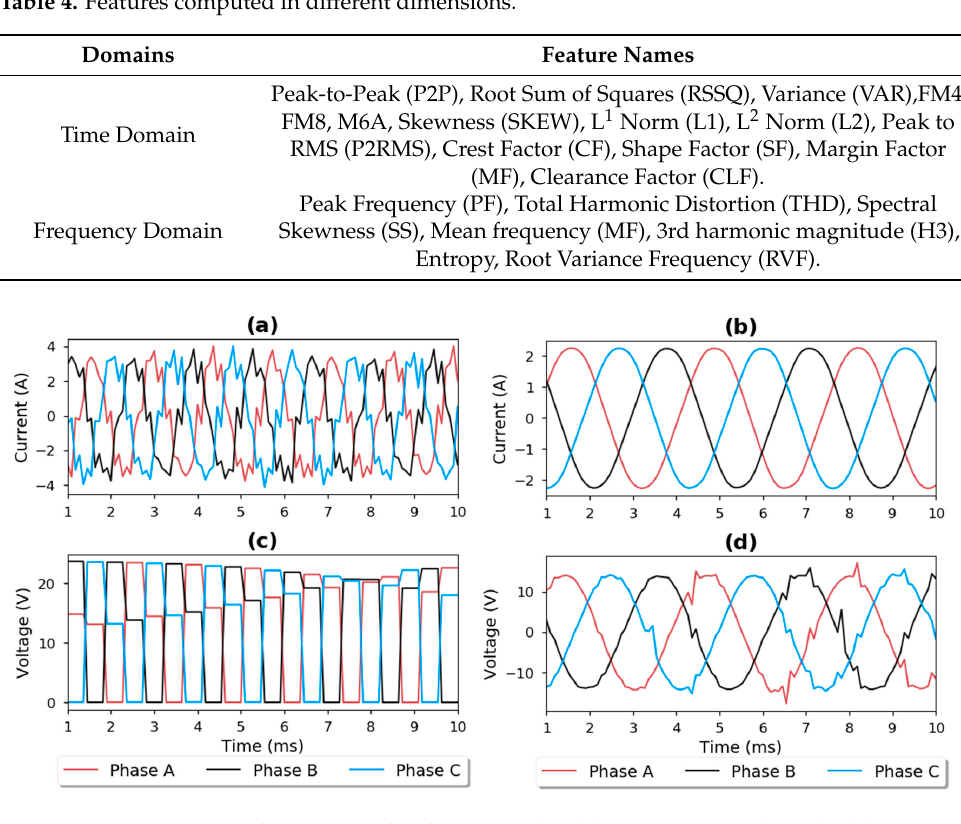
Table 4. Features computed in different dimensions.